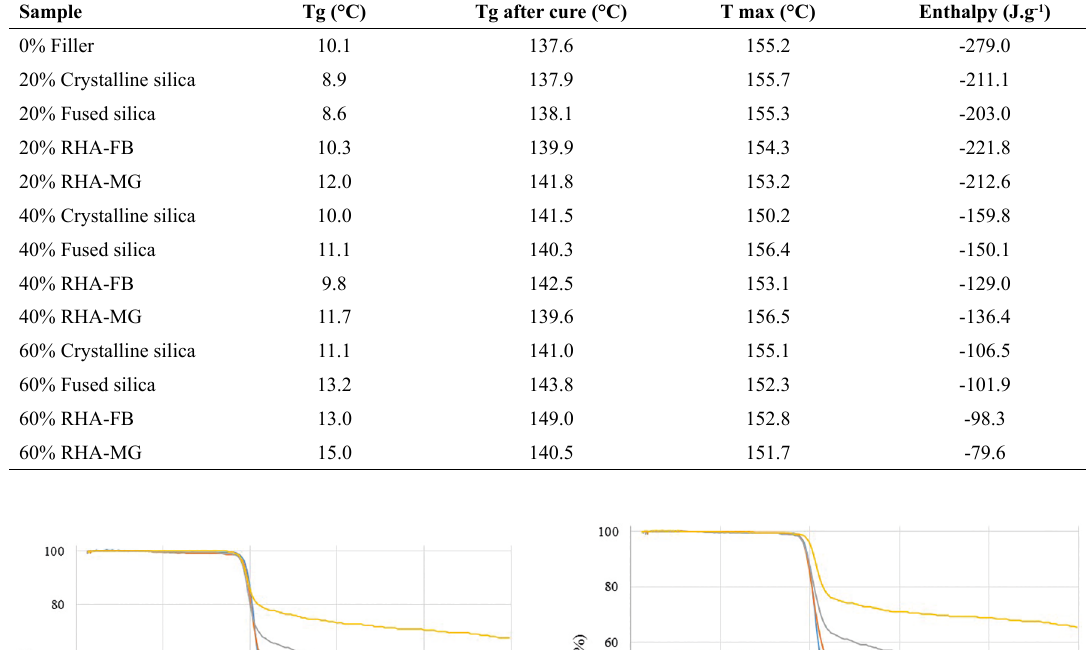
Table 2. DSC parameters of mixtures prepared with 0% filler different proportions of crystalline silica, fused silica, RHA-FB, and RHA-MG